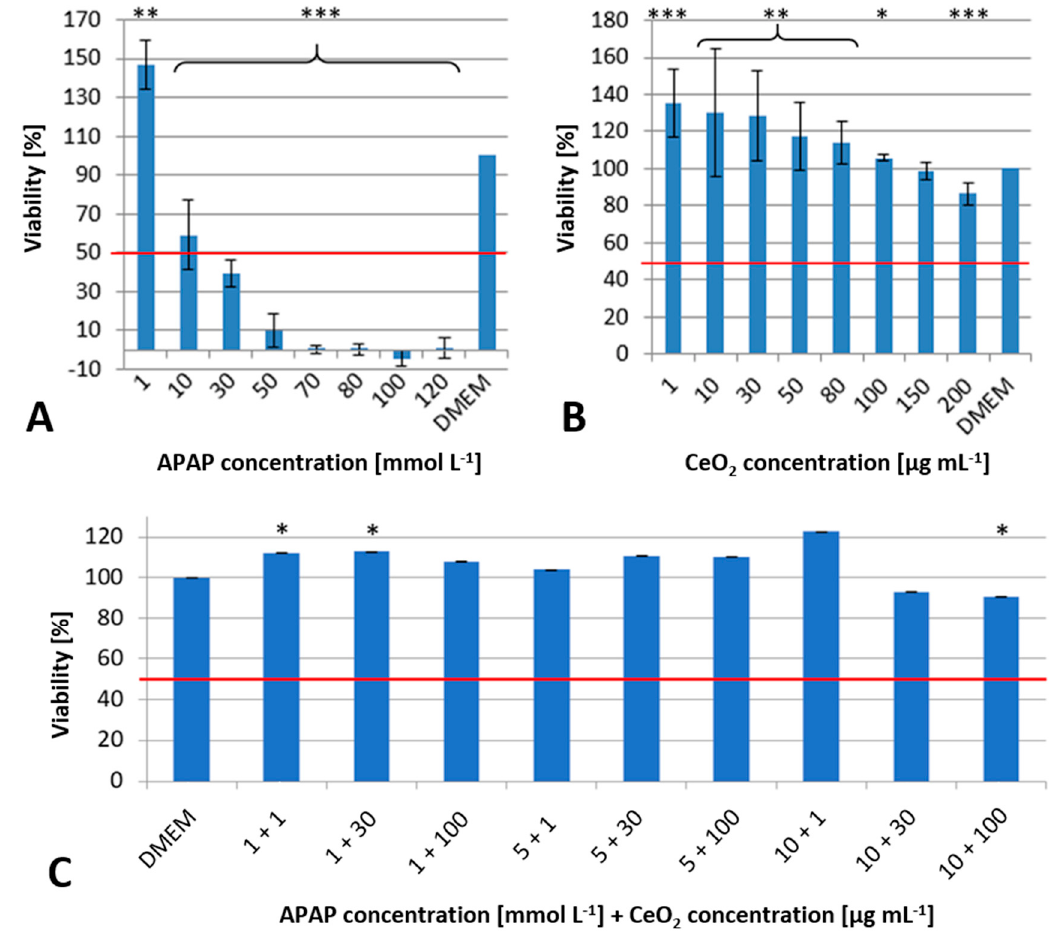
Figure 2. Results of the WST-1 assay after 24 h exposure of HuH-7 cells to APAP ( A ), CeO 2 NPs ( B ) and both in combination ( C ) at different concentrations ± standard deviation normalized to negative control (Dulbecco’s modified Eagle medium, DMEM) and positive control (TritonX). Red line indicates the EC50 (effective concentration where viability is reduced to 50%). All tests with at least three biological and six technical replicates. p ≤ 0.05 = *, 0.01 = **, 0.001 = ***.